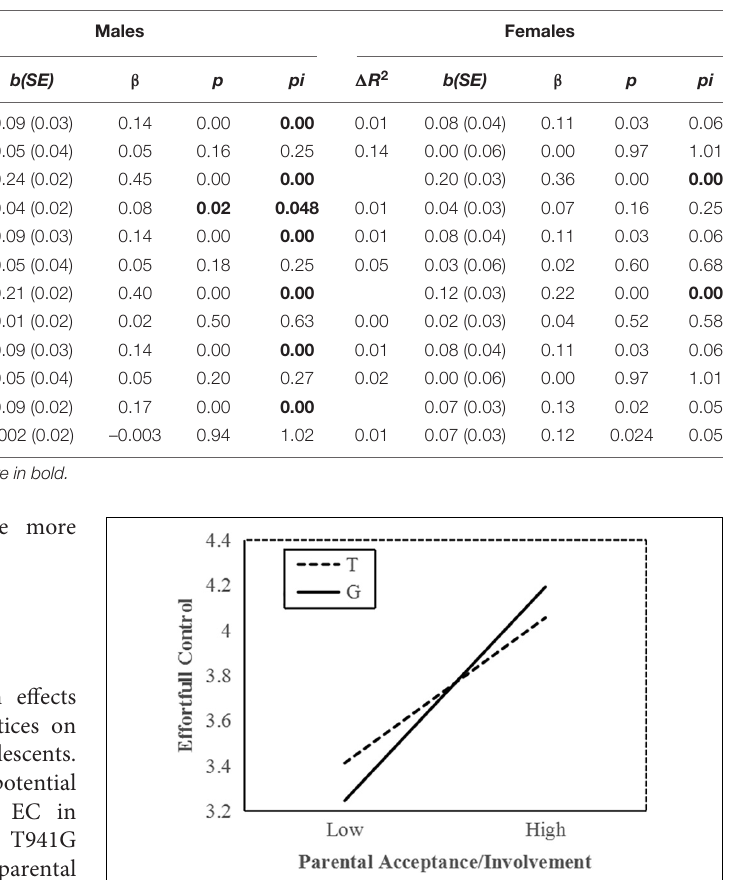
TABLE 2 | Hierarchical linear regression analysis of the associations among MAOA T941G, parenting practices, and effortful control.